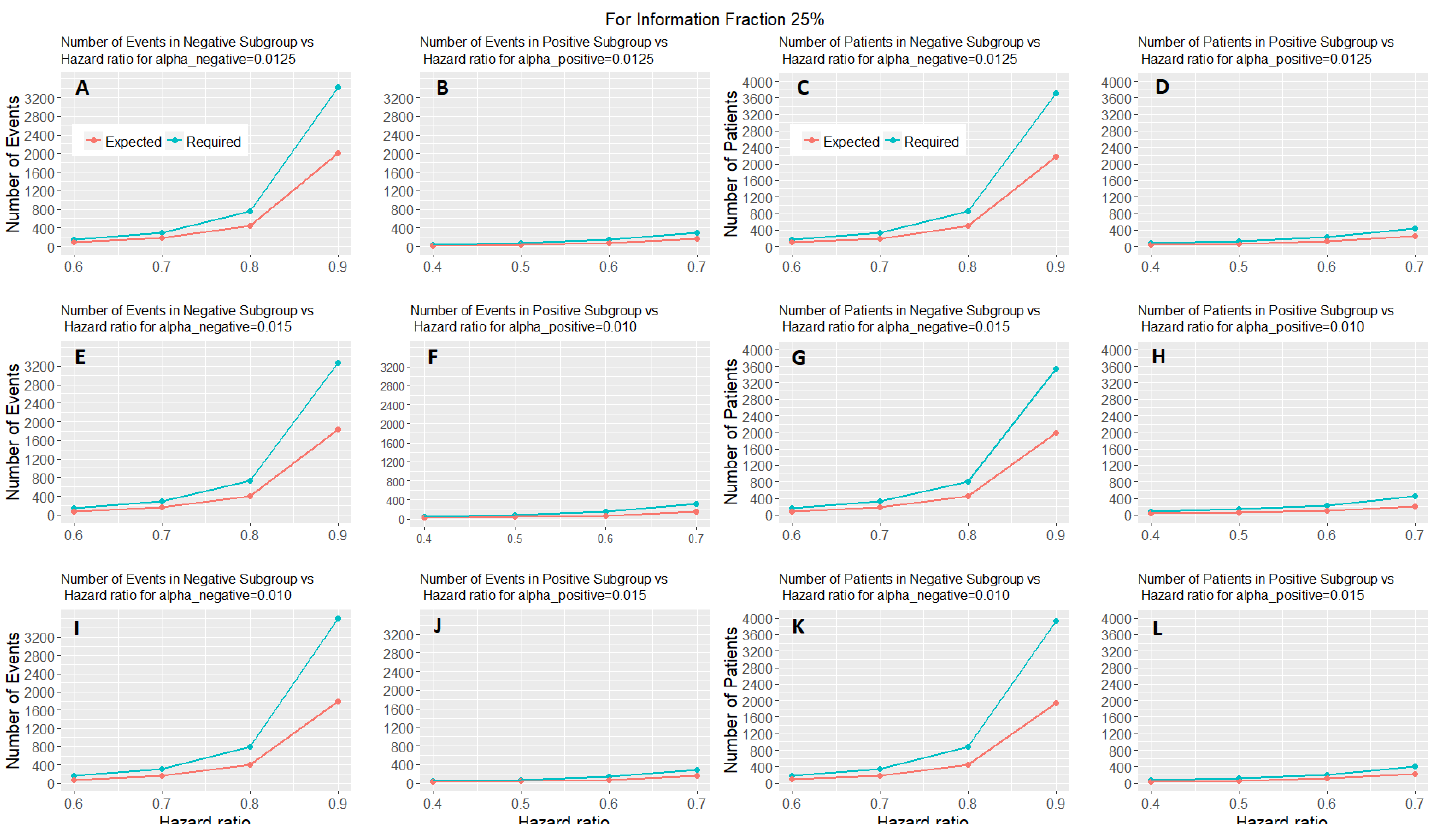
Figure 6. Expected number of events and patients in two-stage design and required number of events and patients in one-stage design for each biomarker-defined subgroup versus the hazard ratios of each biomarker-defined subgroup when the interim fraction is 25%. The first two graphical representations in each row of graphs represent the number of events versus the hazard ratio of each biomarker-defined subgroup when (i) a − = a + = 0.0125 in ( A , B ), (ii) a − = 0.015 and a + = 0.010 in ( E , F ), and (iii) a − = 0.010 and a + = 0.015 in ( I , J ) respectively. The remaining graphical representations in each row of graphs represent the number of patients versus the hazard ratio of each biomarker-defined subgroup when (i) a − = a + = 0.0125 in ( C , D ), (ii) a − = 0.015 and a + = 0.010 in ( G , H ), and (iii) a − = 0.010 and a + = 0.015 in ( K , L ),